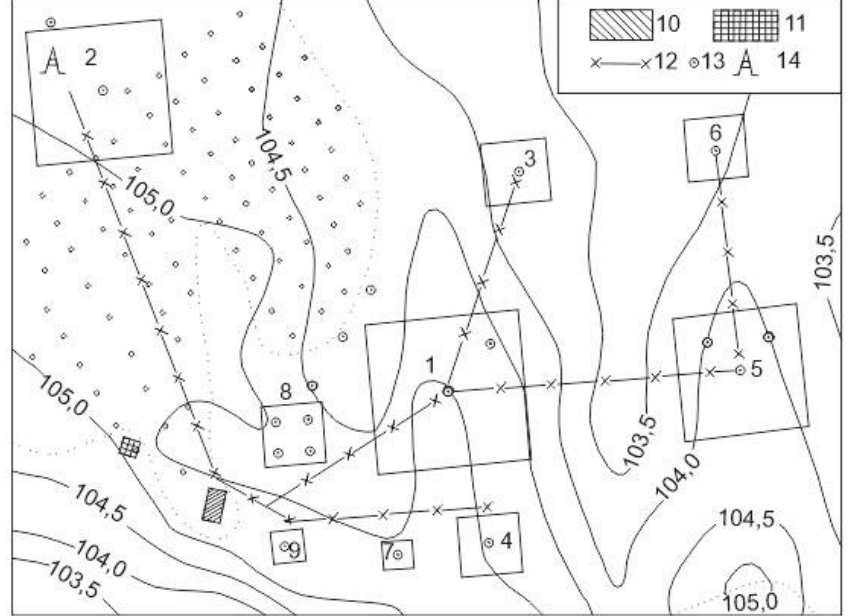
Figure 2. Scheme of the experimental sites of the Yakutsk Heat Balance Station [16]. (1) natural, treeless; (2) in the forest; (3) stripped surface; (4) asphalted; (5,6)—with film covers; (7) with plank blind areas; (8) with heat-insulating coatings; (9) with artificial moisture; (10) heat balance pavilion; (11) battery room; (12) communication and power supply lines; (13) thermometric borehole; (14) tower in the forest.